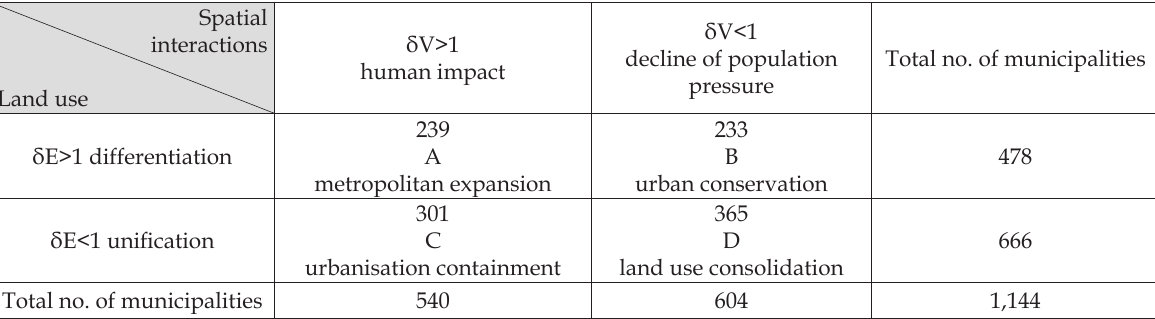
Table 3. Types of relations between quotients of population potential and quotients of entropy indices by num- ber of municipalities (2006/2000, see explanation in